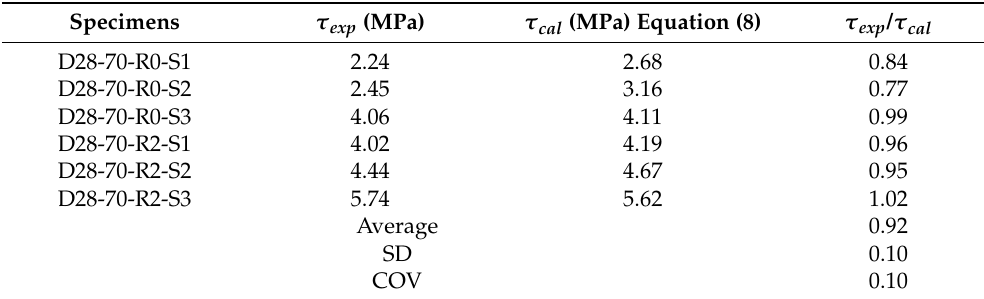
Table 8. Comparison of the shear bond stress between the experimental Equation